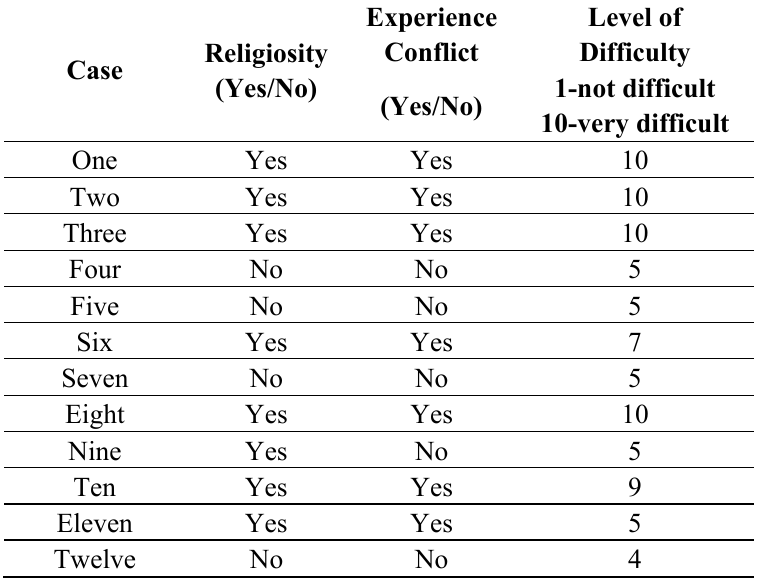
Table 1. Religiosity, experience of conflict, and level of difficulties.